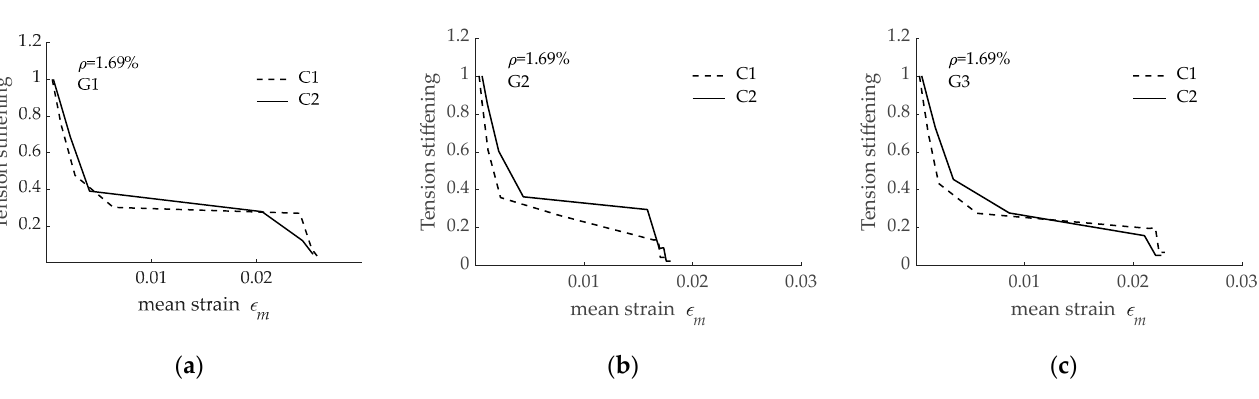
Figure 12. Tension stiffening effect corresponding to RC tensile elements reinforced with bars G1, G2, and G3 and concrete C2.